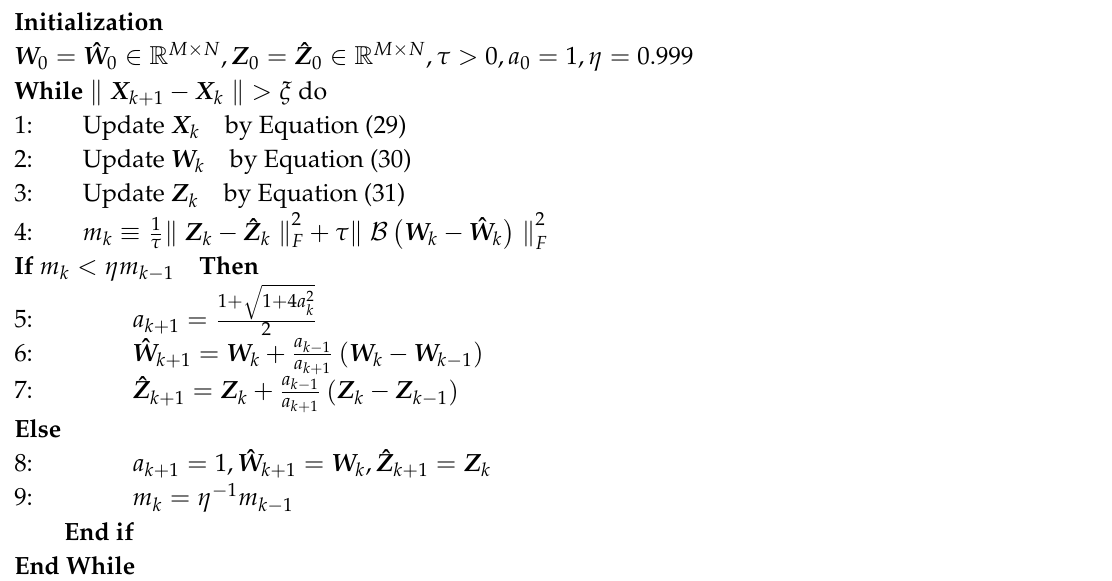
Algorithm 2: GBTR-A2DM2 algorithm using restarting rule.